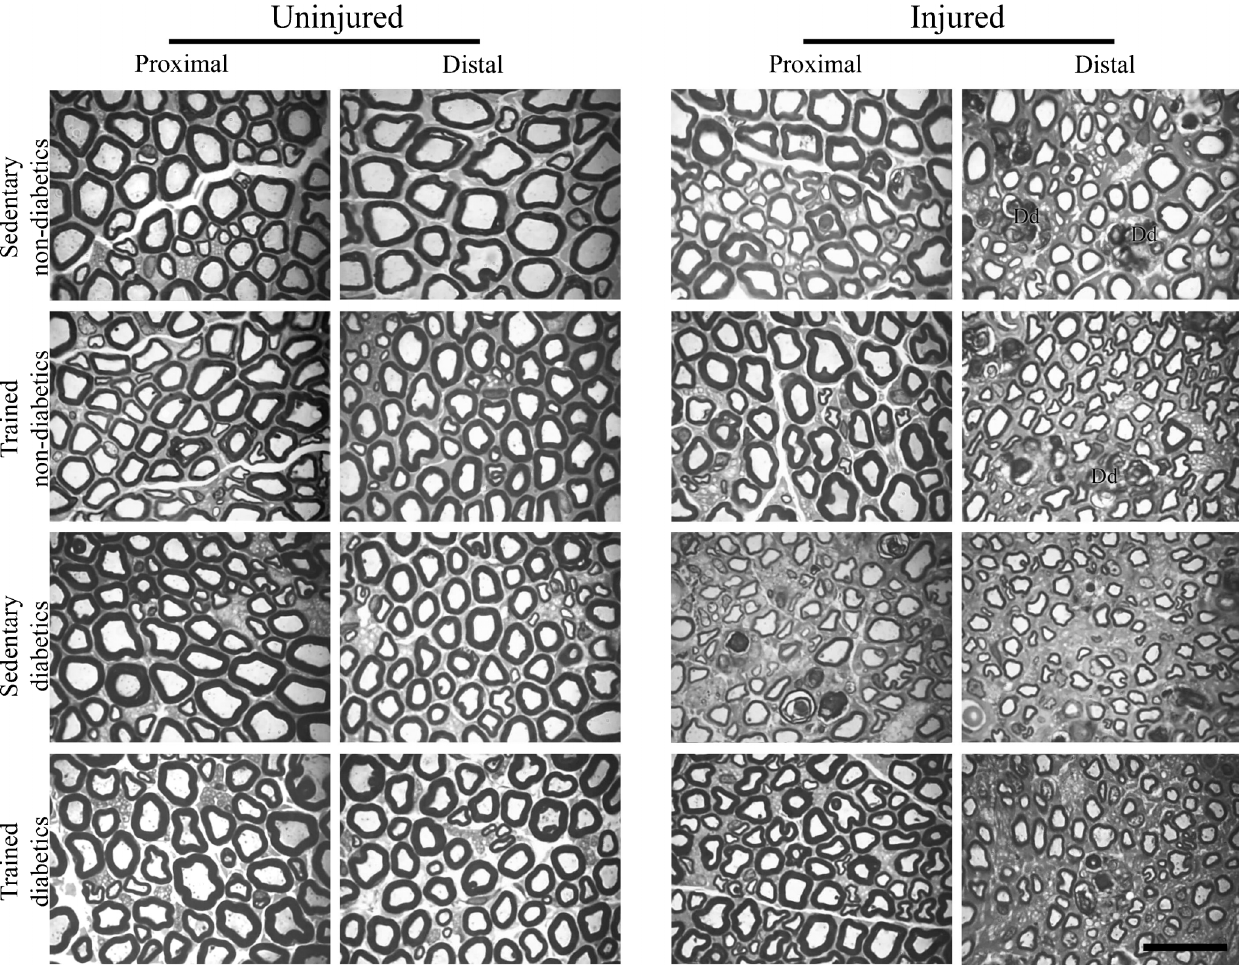
Figure 3 - Digitized images of semithin cross-sections obtained from the proximal and distal portions of the sciatic nerve from different groups in this study. Note the predominance of small thin myelinated fibers, enlargement of the space occupied by endoneurial tissue and presence of degenerative debris in the distal nerve portion of all injured groups and proximal nerve portion of the sedentary diabetic injured group. Dd; degenerative debris. Toluidine blue stained. Bar = 20 m